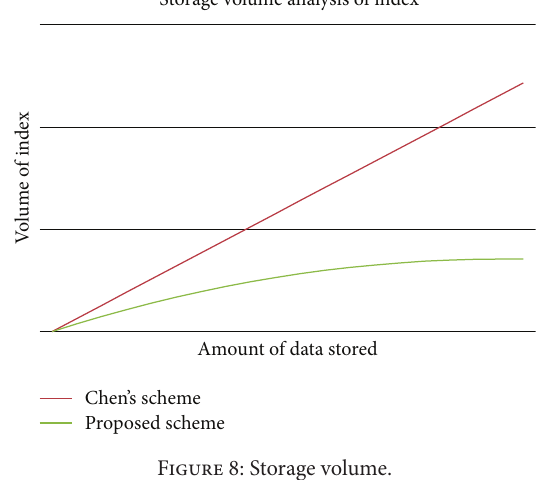
Figure 7: Search speed.